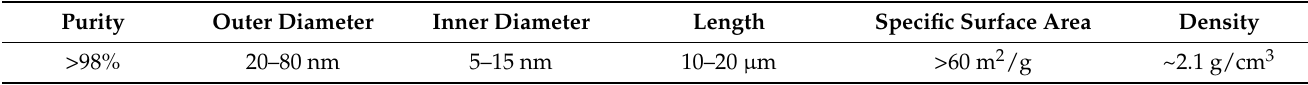
Table 1. Characteristics of carbon nanotubes (CNT) provided by the supplier.